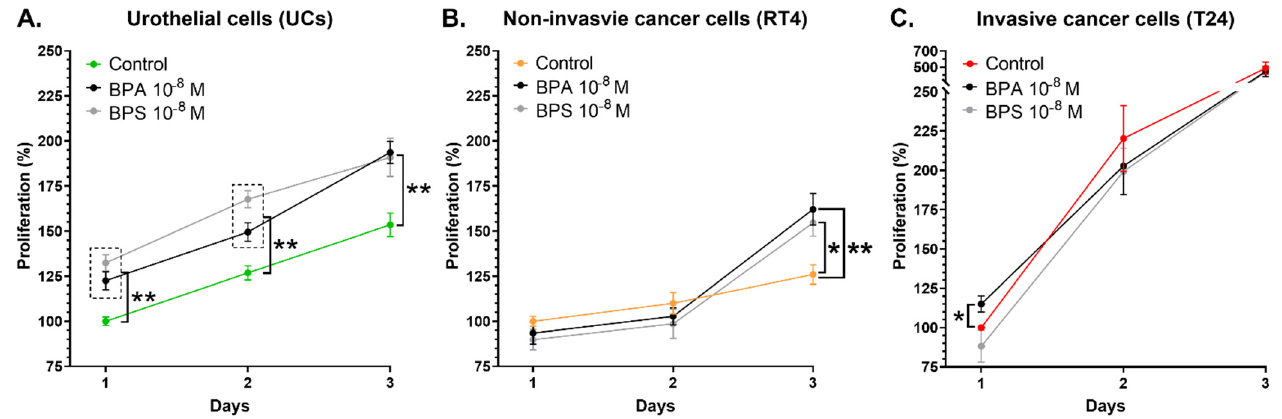
Figure 5. Chronic exposure to physiological concentrations of BPA or BPS increases the proliferation rate of RT4 non-invasive bladder cancer cells and induces an initial boost of proliferation for UCs and T24 cells. The proliferation rate of ( A ) normal urothelial cells (UCs), ( B ) RT4 non-invasive bladder cancer cells and ( C ) T24 invasive bladder cancer cells was established over three days with or without chronic exposure to physiological concentrations of BPA or BPS. The proliferation rate is illustrated by the number of cells as a function of time. Data are presented as the mean ± SEM and displayed as percentages of controls at day 1 (i.e., untreated condition) (n = 3, N = 3). * p < 0.05, ** p < 0.01 by Mann–Whitney test.